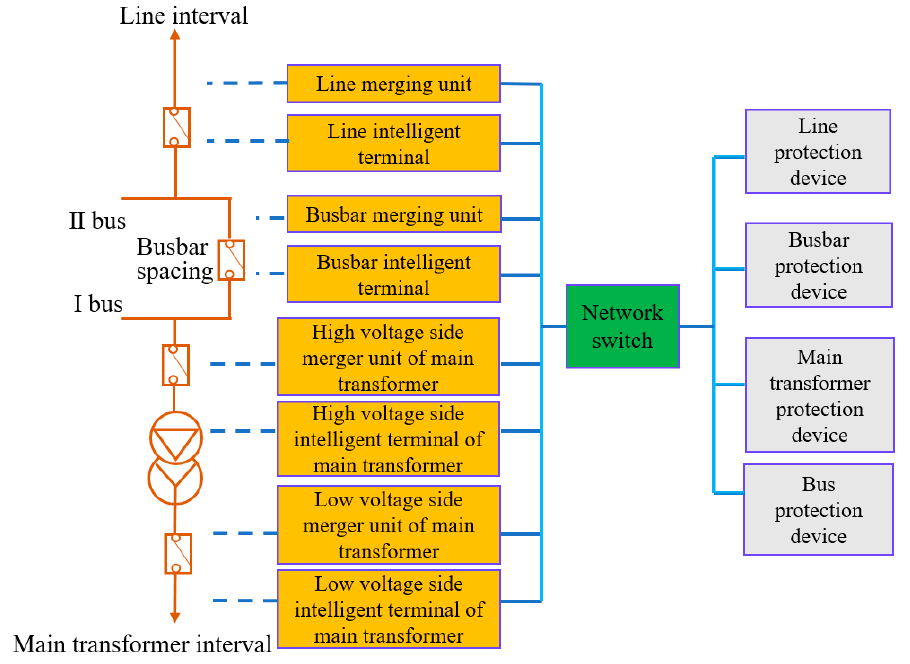
Figure 1. Protection device (PD) configuration of a typical connection mode of a 220 kV bus.